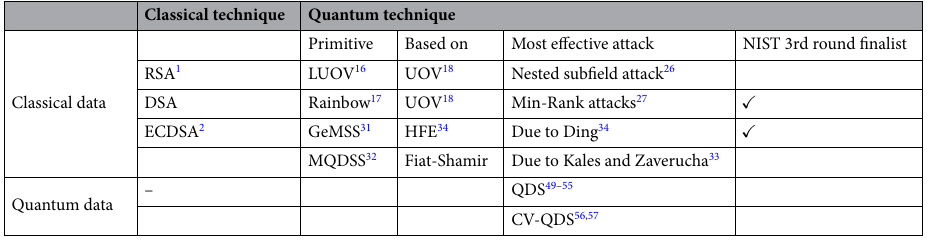
Table 1. Summary of related